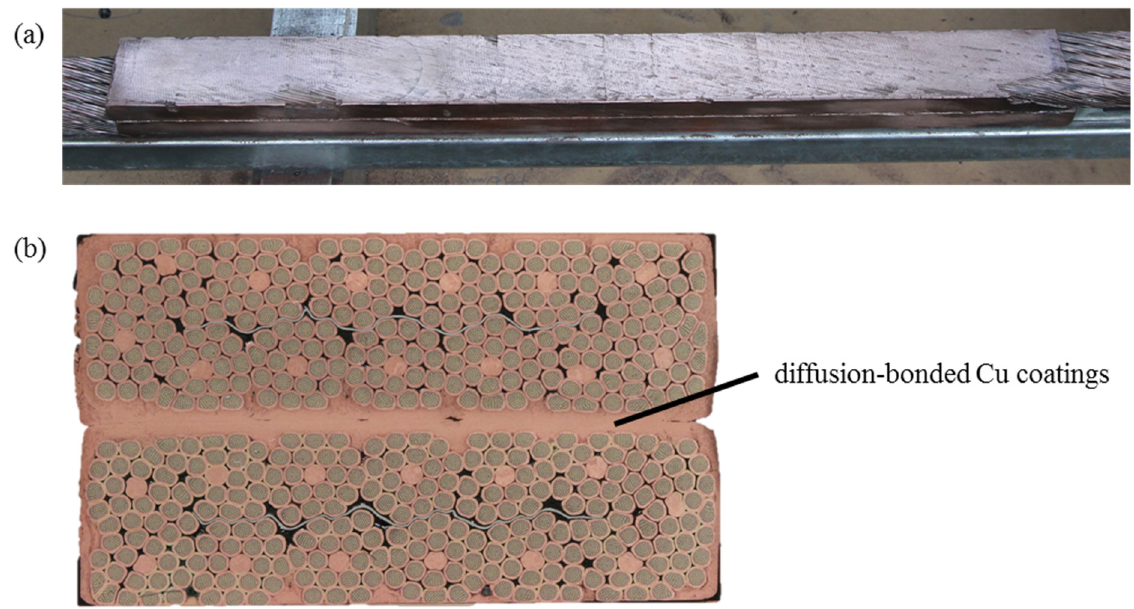
Figure 2. Diffusion-bonded joint between Nb 3 Sn cables coated with copper thermal spraying ( a ) and cross-section of the joint ( b ).